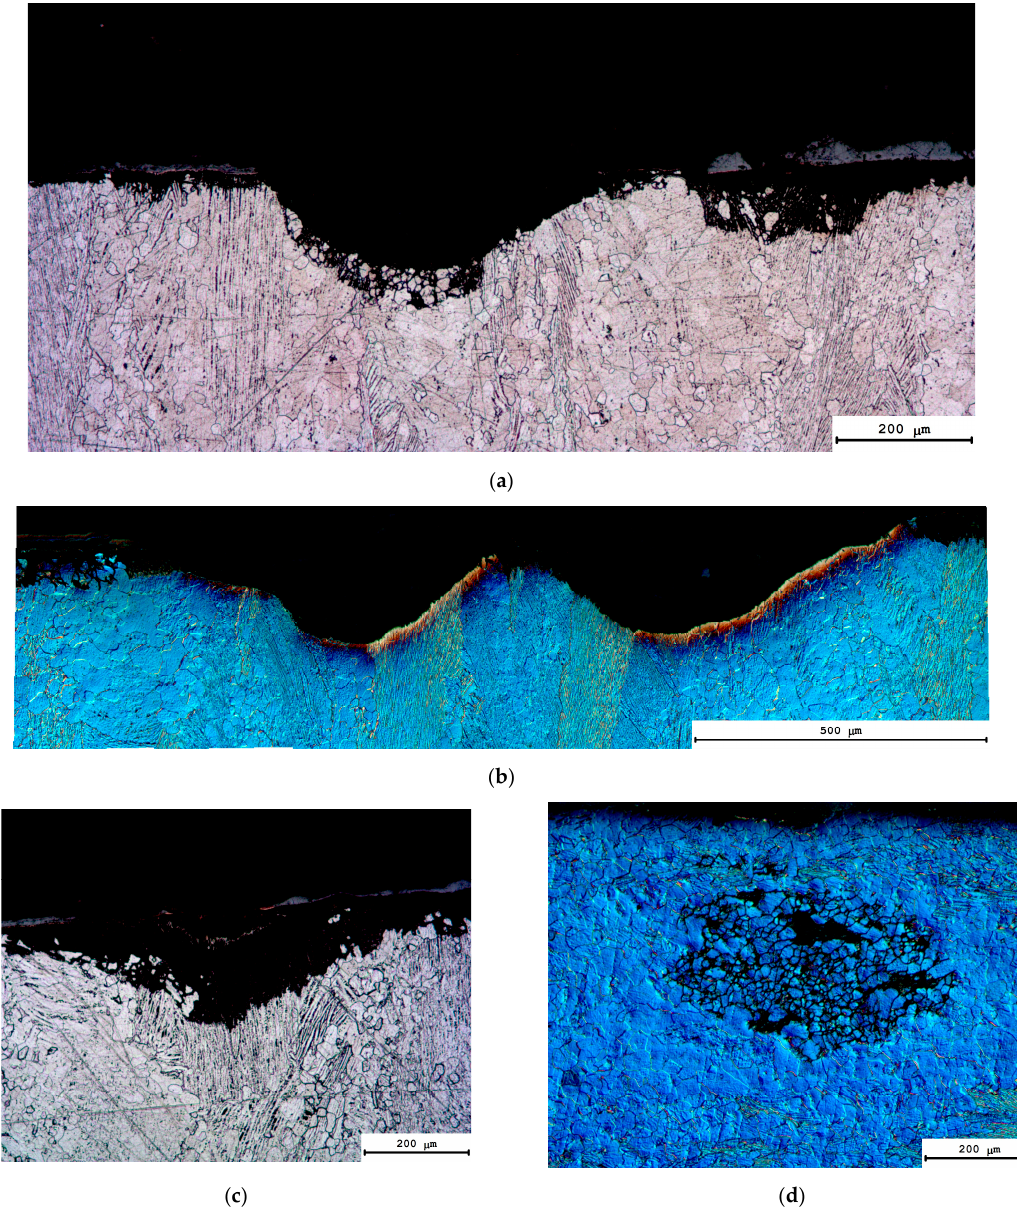
Figure 14. The nonuniform distribution of large corrosion pits at different sides of the joint line of the coarse-grained alloy after HSC testing: ( a ) V h = 100 ◦ C/min, t = 700 ◦ C, t = 10 min, P = 50 MPa; ( b ) V h = 100 ◦ C/min, t = 700 ◦ C, t = 10 min, P = 100 MPa. Examples of defect formation in the plate-wise α -phase regions are presented in ( c , d ).